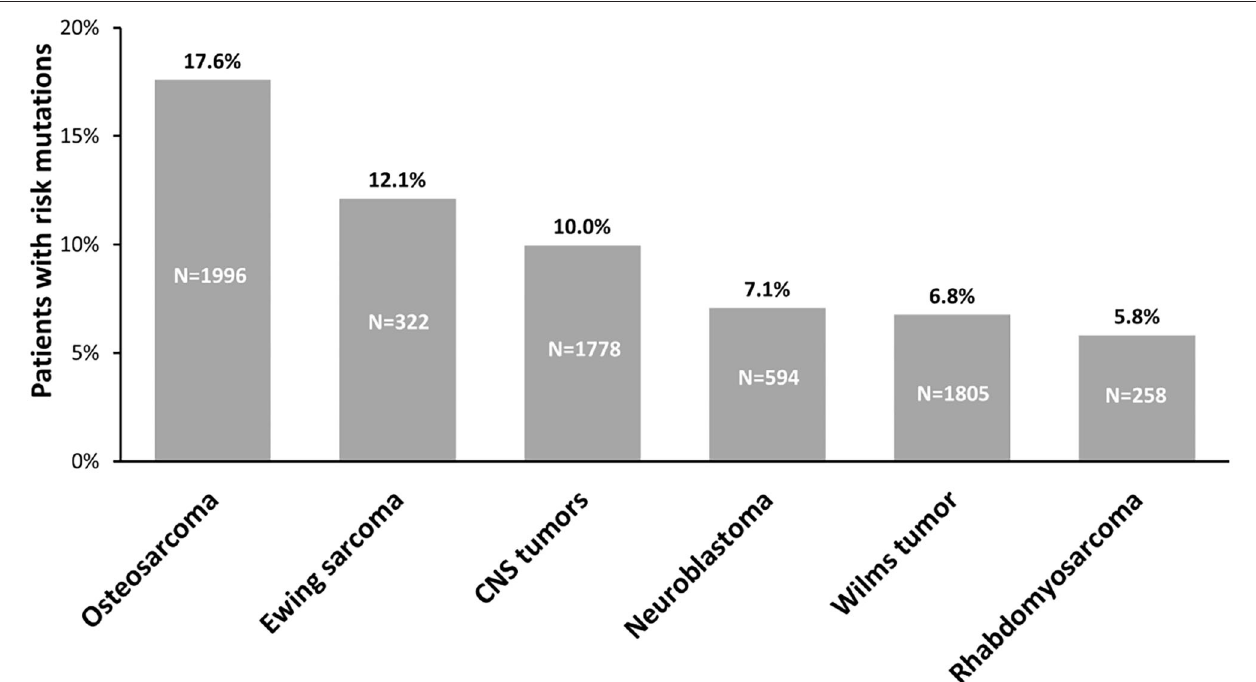
FIGURE 3 | Prevalence of germline predisposition in pediatric tumors. The percentage of germline predisposition due to uncommon, moderate-penetrance variants, reported above the bars, has been calculated evaluating the number of patients carrying pathogenic and likely pathogenic variants on the total number of patients from the cohorts analyzed for each tumor: CNS tumors: (3, 15, 17); neuroblastoma: (2, 3, 135, 146, 196, 197, 200); Wilms tumor: (3, 131, 132, 137, 148, 150, 251); osteosarcoma: (2, 3, 129, 138); rhabdomyosarcoma: (2, 3, 52, 139); Ewing sarcoma: (2, 3, 130, 146). N, number of patients analyzed in cohorts; CNS, central nervous